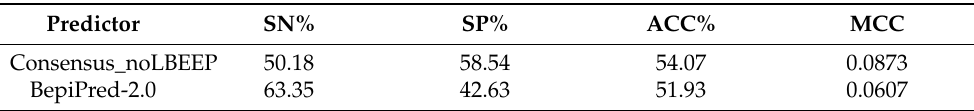
Table 8. Comparison of the performance of our consensus predictor and BepiPred-2.0 against the Consensus_NR data set. Predictor SN% SP% ACC% MCC Consensus_noLBEEP